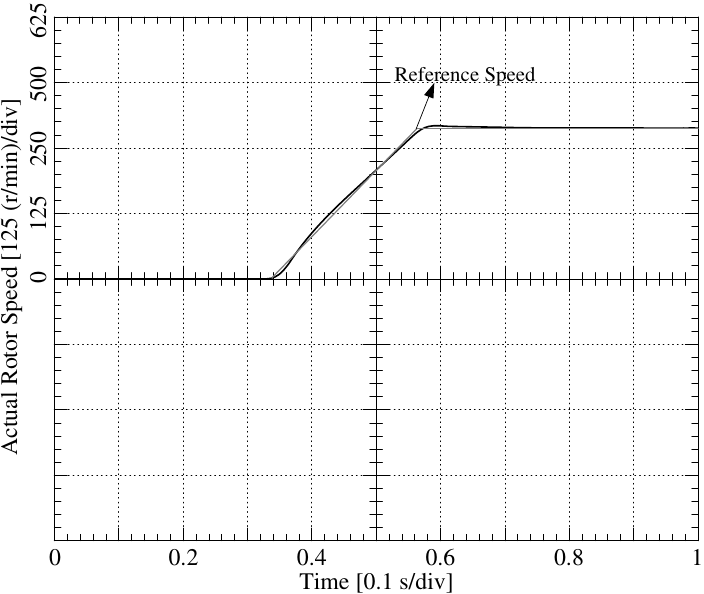
Figure 7. Experimental no-load ramp speed response (referenced 0 to 360 r/min in 2 s) without parameter detuning when K = 1